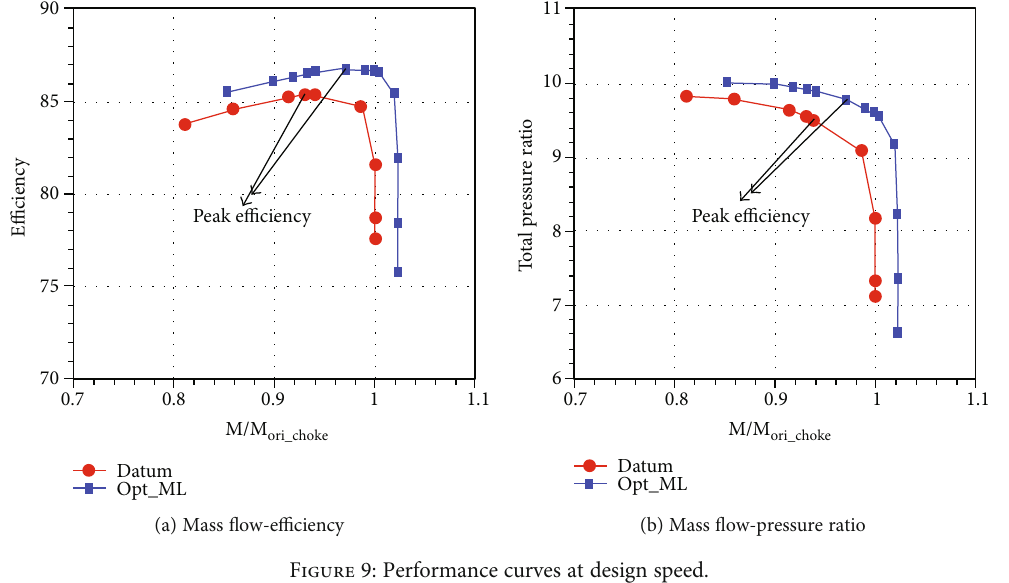
Figure 9: Performance curves at design speed.